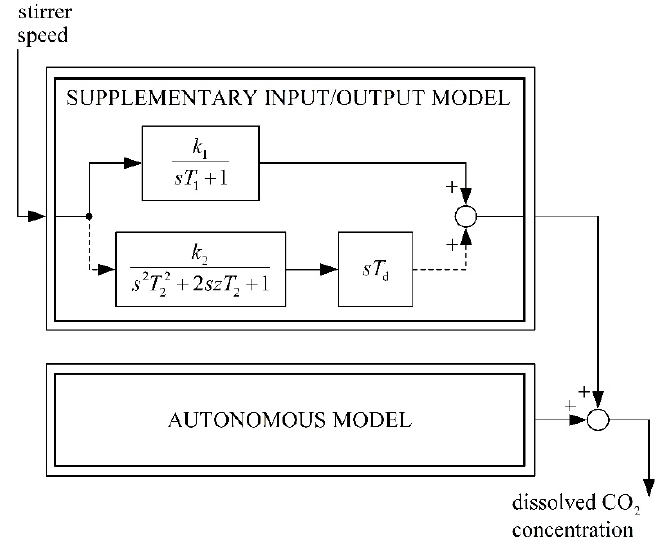
Figure 2. Block diagram of the enhanced mathematical model of a fermentation process in a batch bioreactor with changeable stirrer speed.